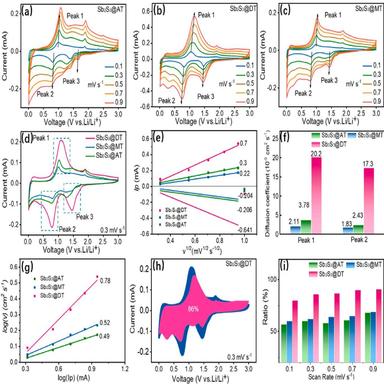
CV curves of Sb2S3@AT(a), Sb2S3@DT(b), and Sb2S3@MT(c) at different scan rates, including 0.1, 0.3, 0.5,0.7 and 0.9 mV s − 1 . CV curves of as-obtained samples at 0.3 mV s − 1 (d). Linear relation of (e) Ip and scan rate at peak 1 and peak 2 and (f) D values of as-prepared samples. Linear relation of as-fabricated samples between log(v) and log(Ip) at peak 1/2 (g), the capacitive contribution at 0.3 mV s − 1 (h), and the ratio of capacitive contributions(i) at different scan rates, including 0.1, 0.3, 0.5,0